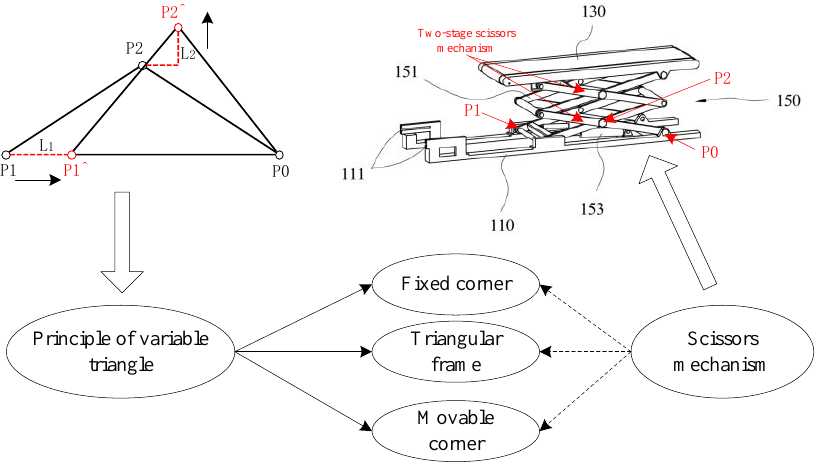
Figure 9. The mapping relation of the working principle/property/structure of the lifting mechanism.